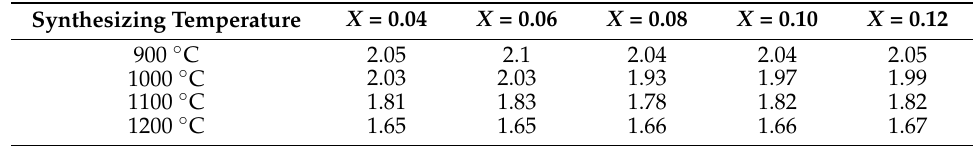
Table 1. Luminescence lifetimes of Sr 2 − x Eu x ZnMoO 6 phosphors as a function of the synthesizing temperature and concentration of Eu 3+ ions.